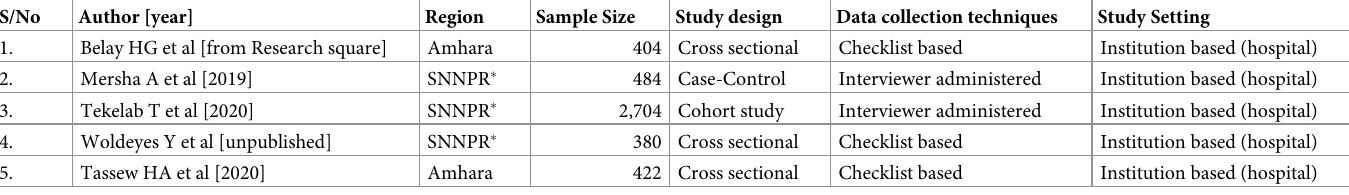
Table 1. Study characteristics included in the systematic review and